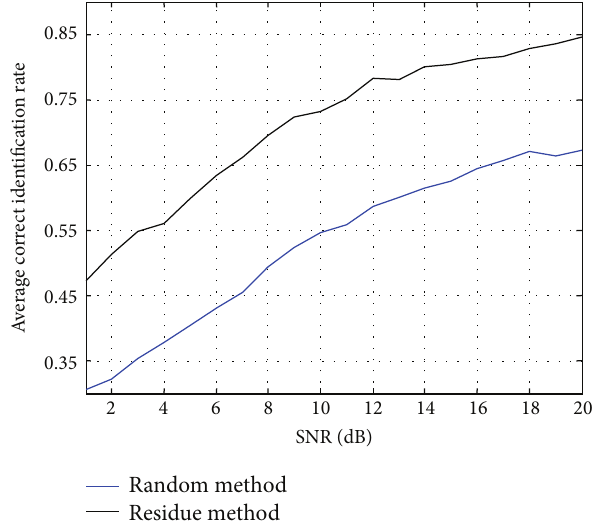
Figure 10: The measuring deviation is ± 2dB, and the frequencies are 4: 13.4 MHz, 15MHz, 16.6MHz, and 20 MHz. rate. But this problem can be overcome by adding more frequency even when the measuring deviation exists, and the average recognition rate of the method adopted in this paper is significantly larger than random selected frequency method, which indicated that the robustness of the method is absolutely better than random selected frequency